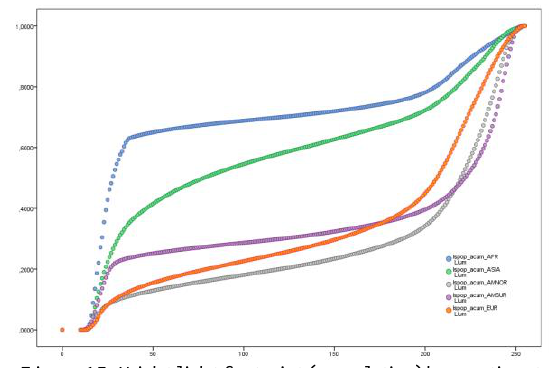
Figure 15. Night light footprint (cumulative) by continent